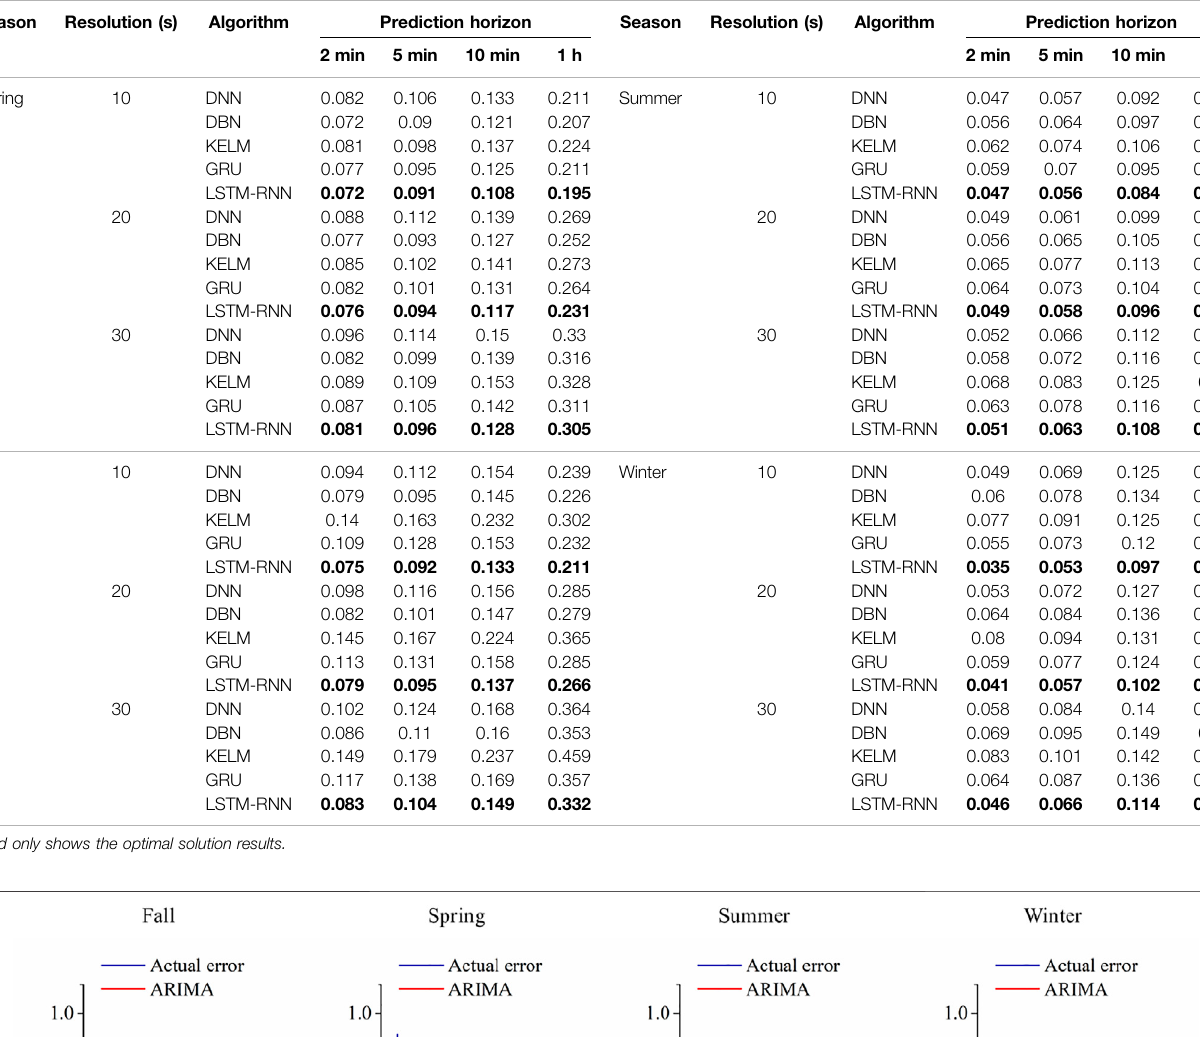
TABLE 1 | Mape of the fi ve algorithms for 2020 before error correction. Season Resolution (s) Algorithm Prediction horizon Algorithm